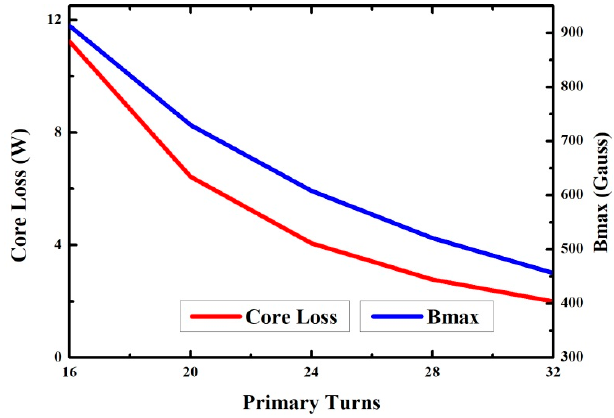
Figure 11. Peak flux density and core loss.